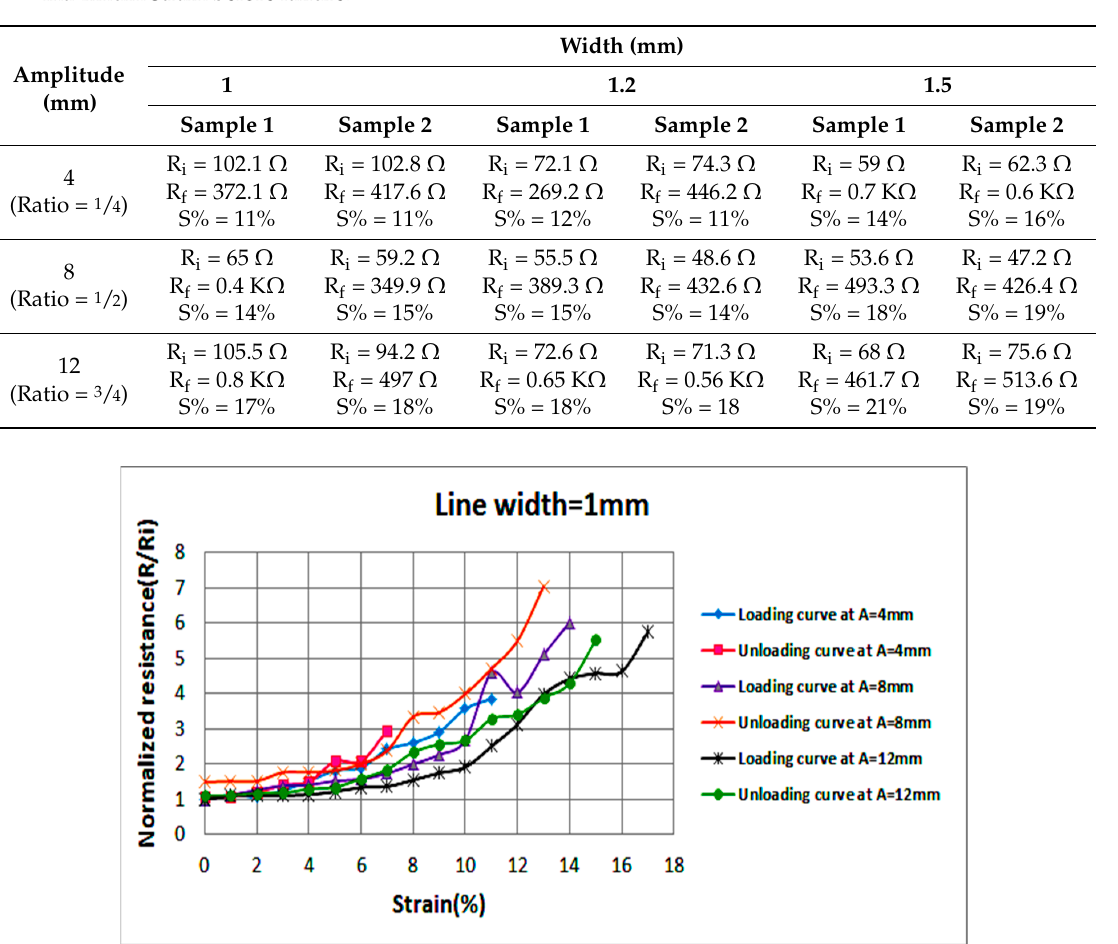
Table 3. Effect of sinusoidal line amplitude and width on initial and final resistances, as well as the maximum strain before failure.